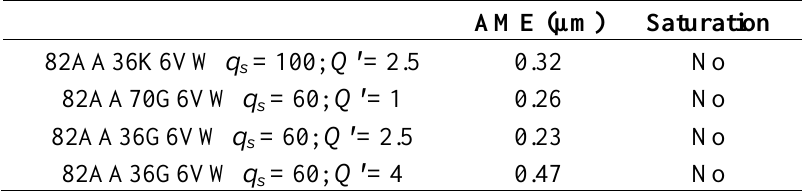
Table 3. Summary of results of the test experiments.